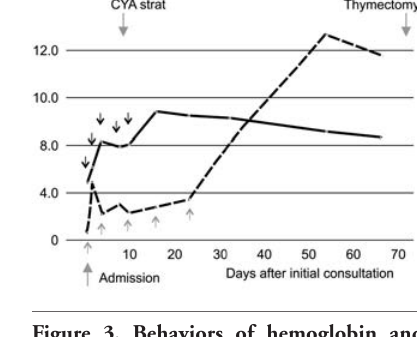
Figure 3. Behaviors of hemoglobin and platelets from the time of admission to thymectomy. The black and broken lines indicate hemoglobin (g/dL) and platelets (×10 4 /µL), respectively. The arrows indi- cate the blood transfusion of red cell con- centrate and platelet concentrate. CYA: